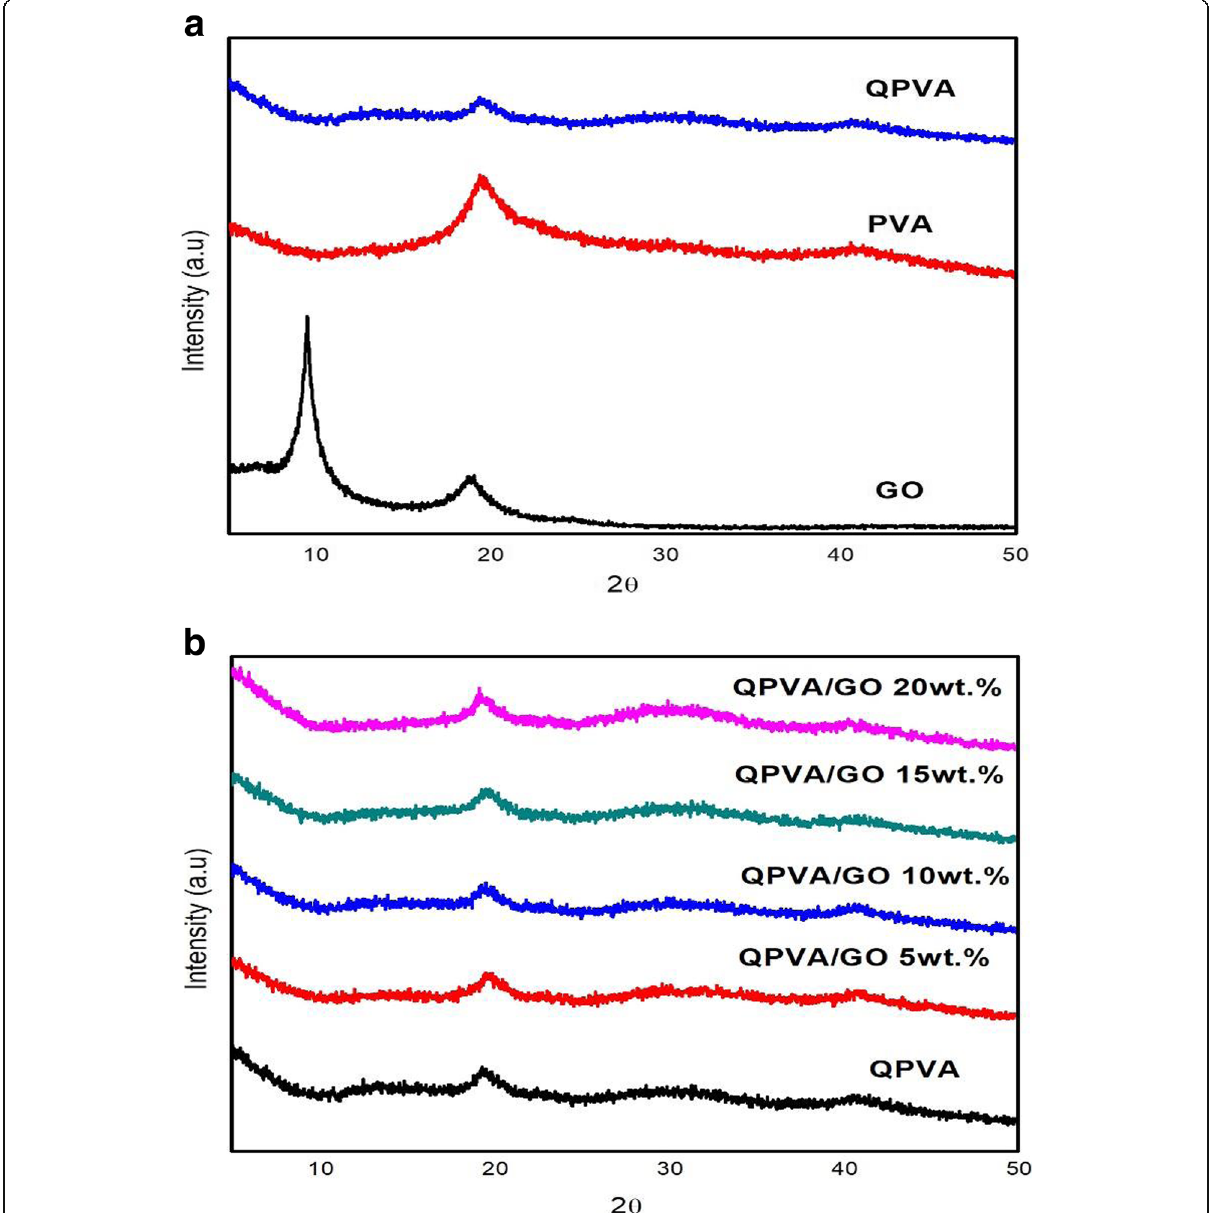
Fig. 4 XRD patterns of a GO, PVA, and QPVA; b QPVA, QPVA/GO composite